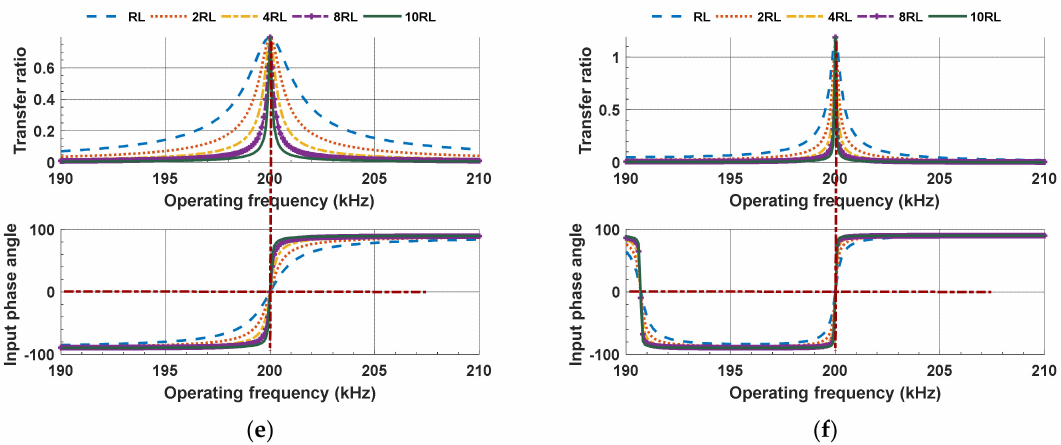
Figure 30. Transfer ratio and phase angle of the input impedance simulation results for ( a ) LC, ( b ) CLC/S, ( c ) S/LC, ( d ) S/LCC, ( e ) S/CLC, and ( f ) S/LC topologies versus operating frequency.